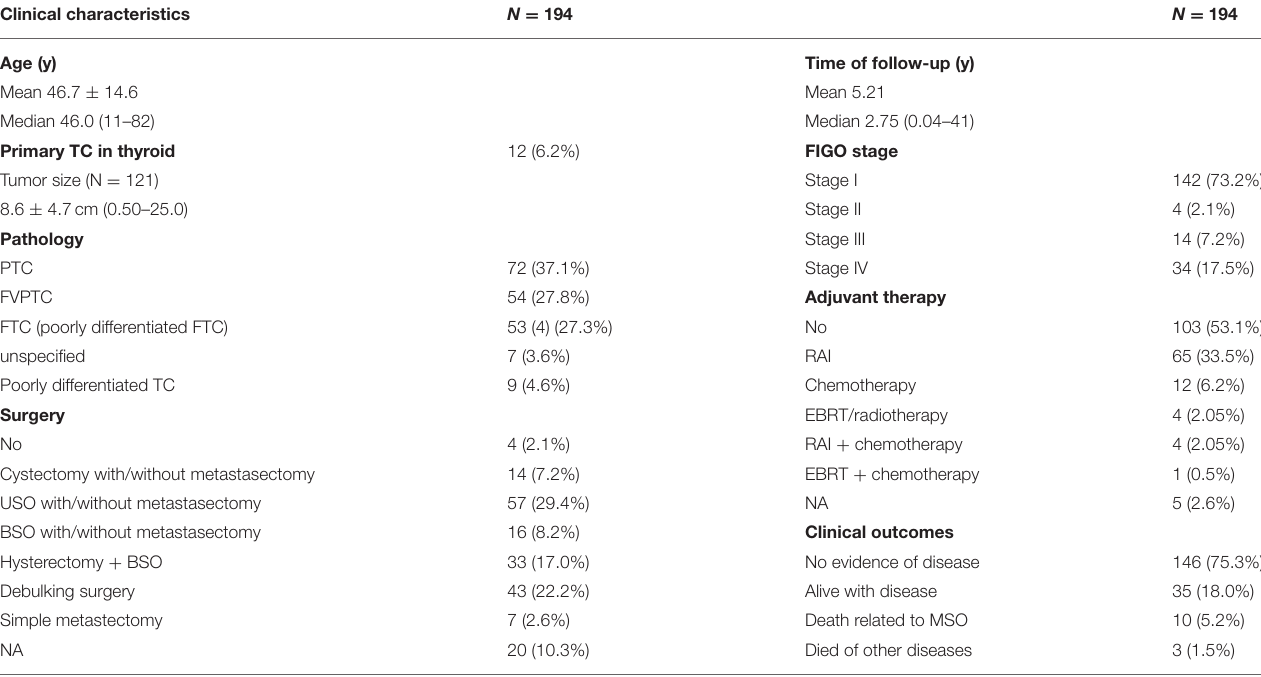
TABLE 1 | Characteristics and clinical outcomes of patients with MSO. Clinical